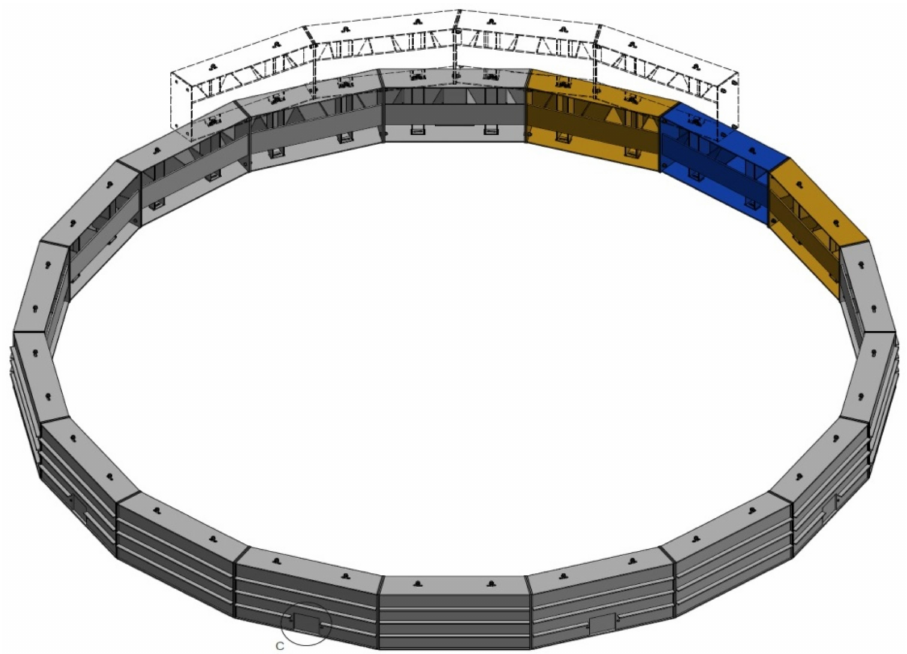
Figure 10. Layout of the steel sections ring (grey panels—typical segments, blue and orange panels— closing segments)